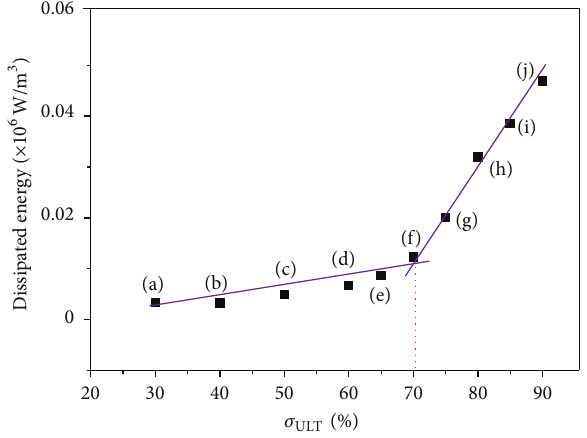
Figure 8: Dissipated energy versus % 𝜎